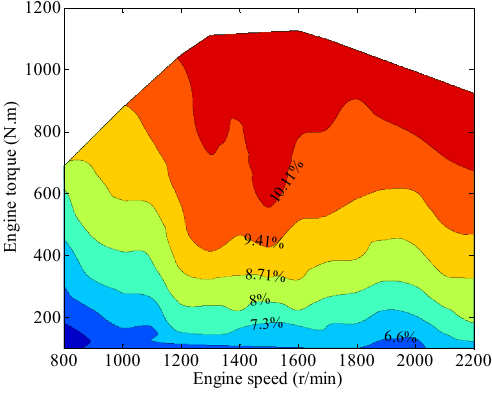
Figure 13. The distribution map of the thermal efficiency of the DORC system.